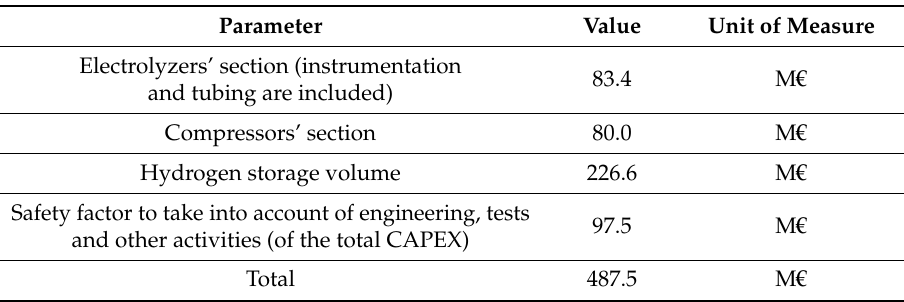
Table 11. Capital expenditure (CAPEX)